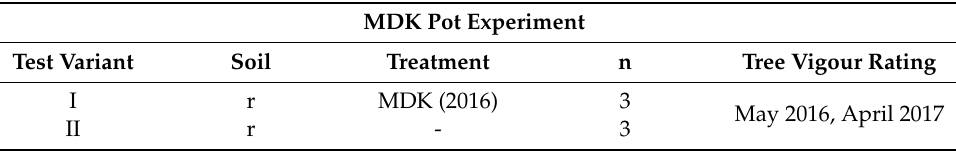
Table 2. MDK Pot Experiment on replant soil (May 2016–April 2017) ( n =